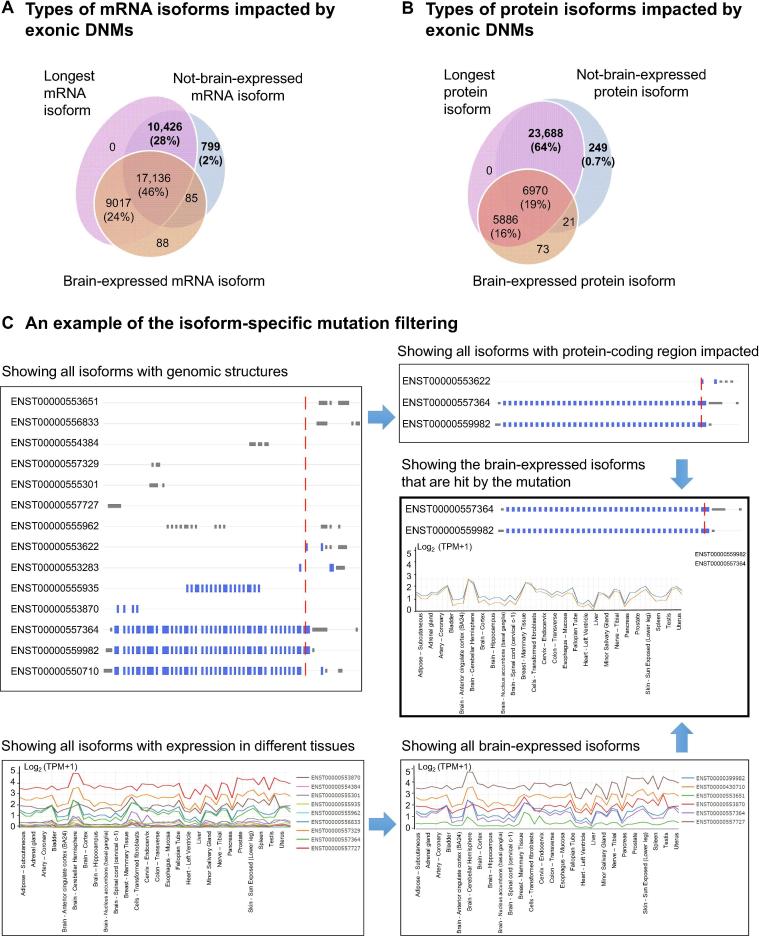
Exploration of mutations at the isoform-levelA. The pie chart shows the overlaps and percentages of DNMs at exonic regions hitting the three different types of mRNA isoforms, illustrating the proportion of DNMs impacting “not-brain-expressed” mRNA isoforms. B. The pie chart shows the overlaps and percentages of DNMs at exonic regions hitting the three different types of protein isoforms, illustrating the proportion of DNMs impacting “not-brain-expressed” protein isoforms. C. An example of the isoform-specific mutation filtering pipeline using a stop-gain DNM in chromosome 14 at position 21,899,618 with a “G > C” change in gene CHD8.